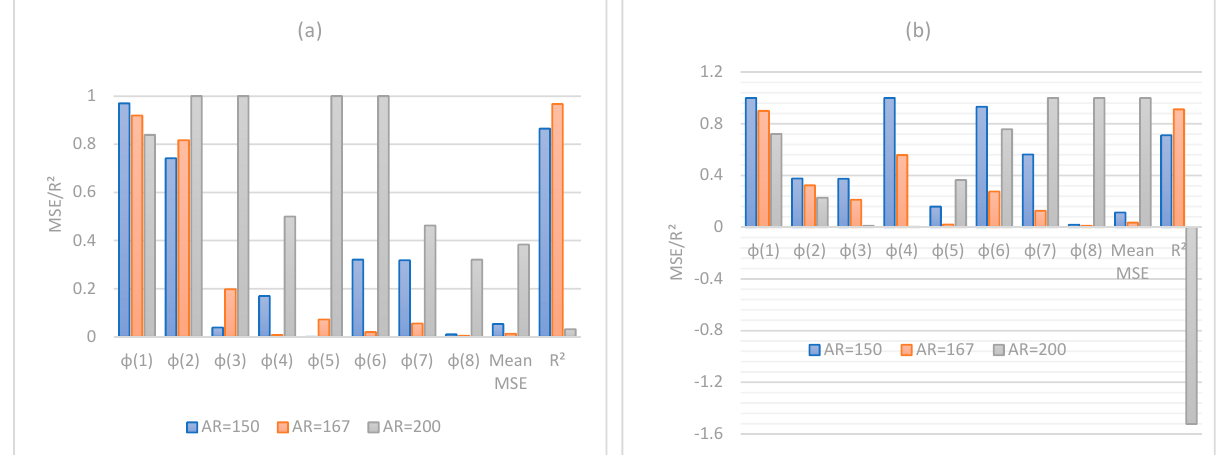
Figure 9. Comparative performance of MSE and R 2 for Mamunya theoretical model, as described respectively by ( a ) Equation (10) and ( b ) Equations (14) and (15). φ (k) values are the experimental concentrations considered in this work, thus corresponding to k samples.